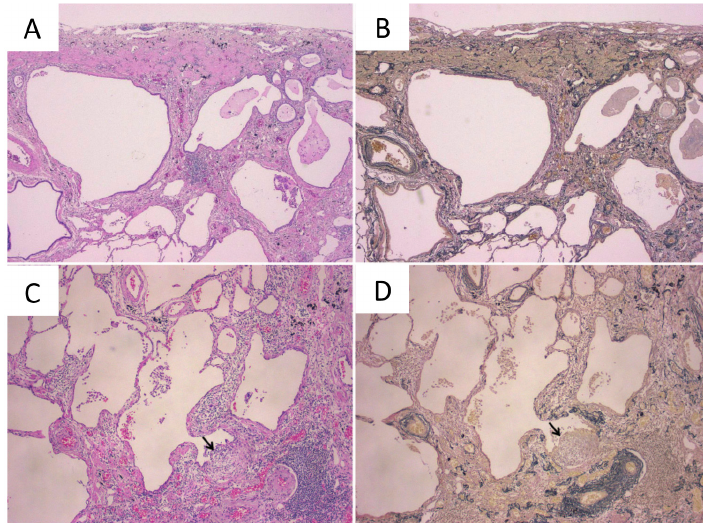
Figure 1. Histopathology of the microscopic usual interstitial pneumonia (UIP) pattern. ( A , B ) Microscopic UIP pattern in the background lung. ( C , D ) The arrow indicates active fibroblastic foci ( A , C , Hematoxylin and eosin staining; B , D , Elastica-van Gieson staining). This figure is adapted from Goto T. Ann